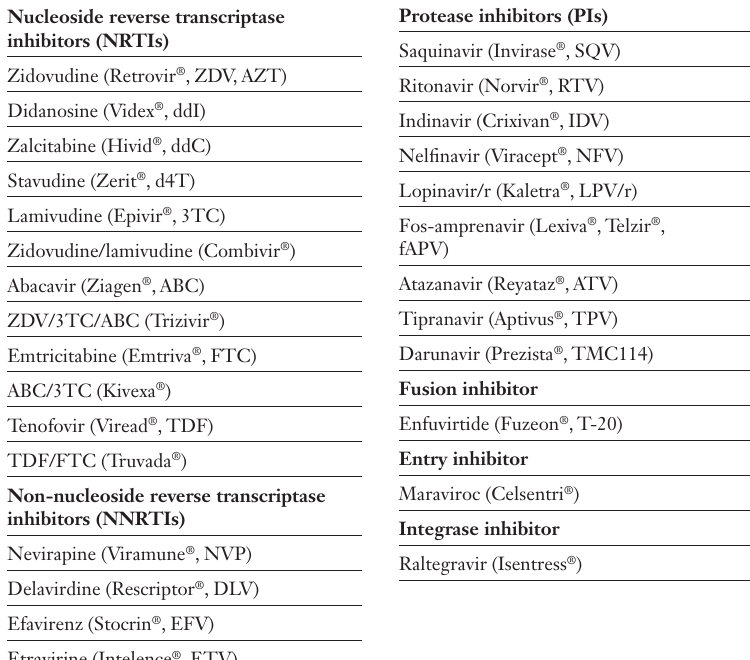
Currently approved drugs for antiretroviral therapy according to drug class.